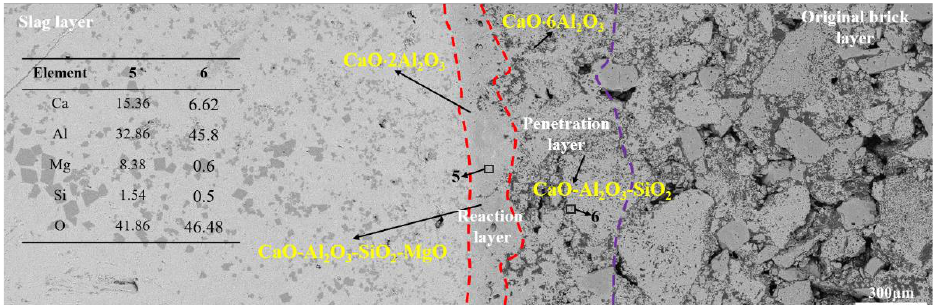
Figure 7. The results of the CA 6 -Al 2 O 3 crucible after corrosion by slag.